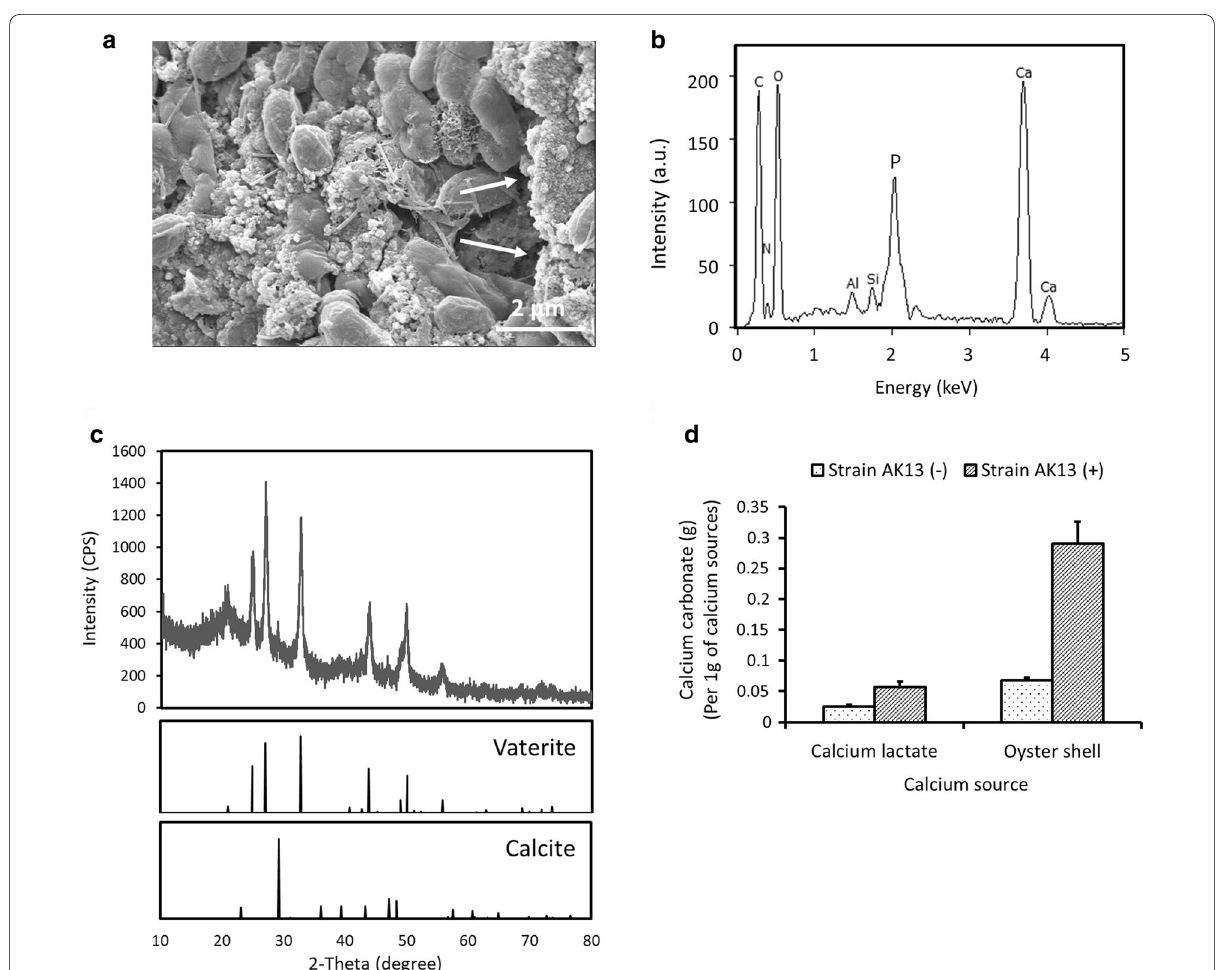
Fig. 4 Calcium carbonate precipitated using oyster shell-derived calcium ions by AK13. a FE-SEM image of calcium carbonate precipitated by AK13 growth in B4O medium. b , c EDX and XRD analysis of calcium carbonate precipitated in B4O medium. d Comparison of the amount of calcium carbonate precipitated by AK13 with the calcium ions separated from the same mass of calcium lactate and oyster shell